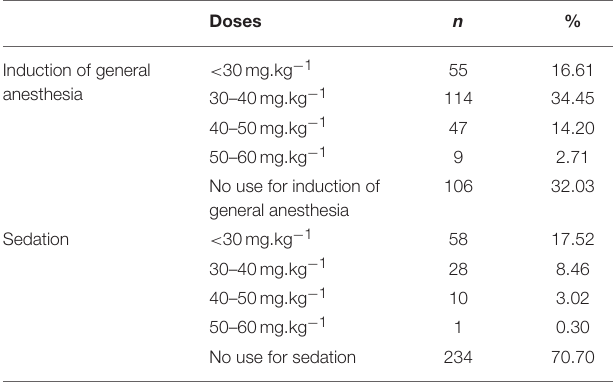
TABLE 3 | Frequency of adverse events during use of magnesium sulfate witnessed at least once by the anesthesiologist. Adverse events n